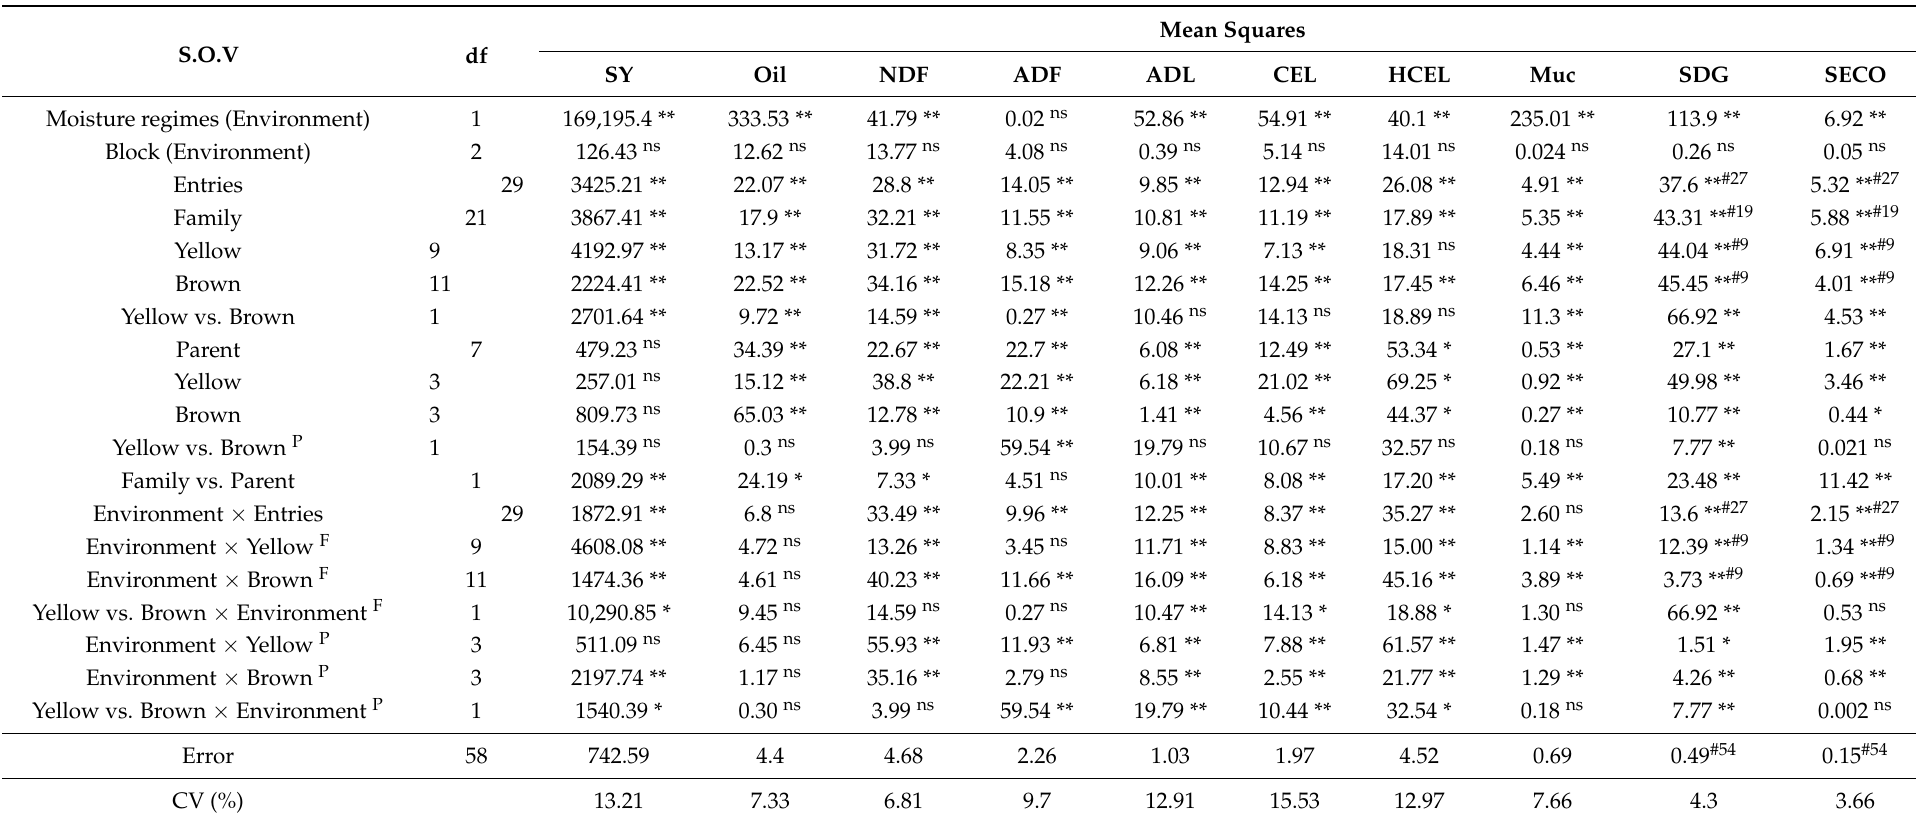
Table 1. Combined analysis of variance (ANOVA) for biochemical characteristics of flaxseeds over two